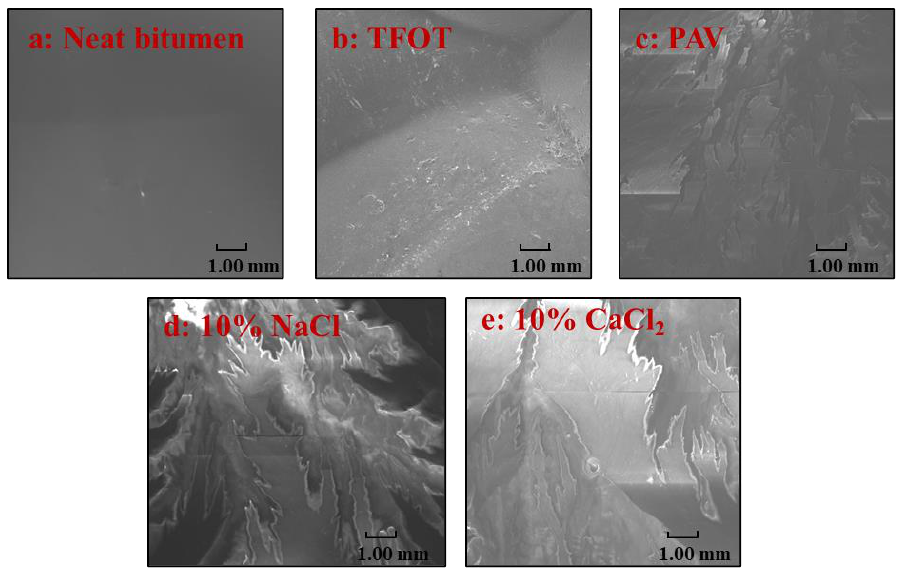
Figure 1. SEM images of bitumen before and aging: ( a ) Neat bitumen; ( b ) TFOT; ( c ) PAV; ( d ) 10% NaCl and ( e ) 10% CaCl 2 .